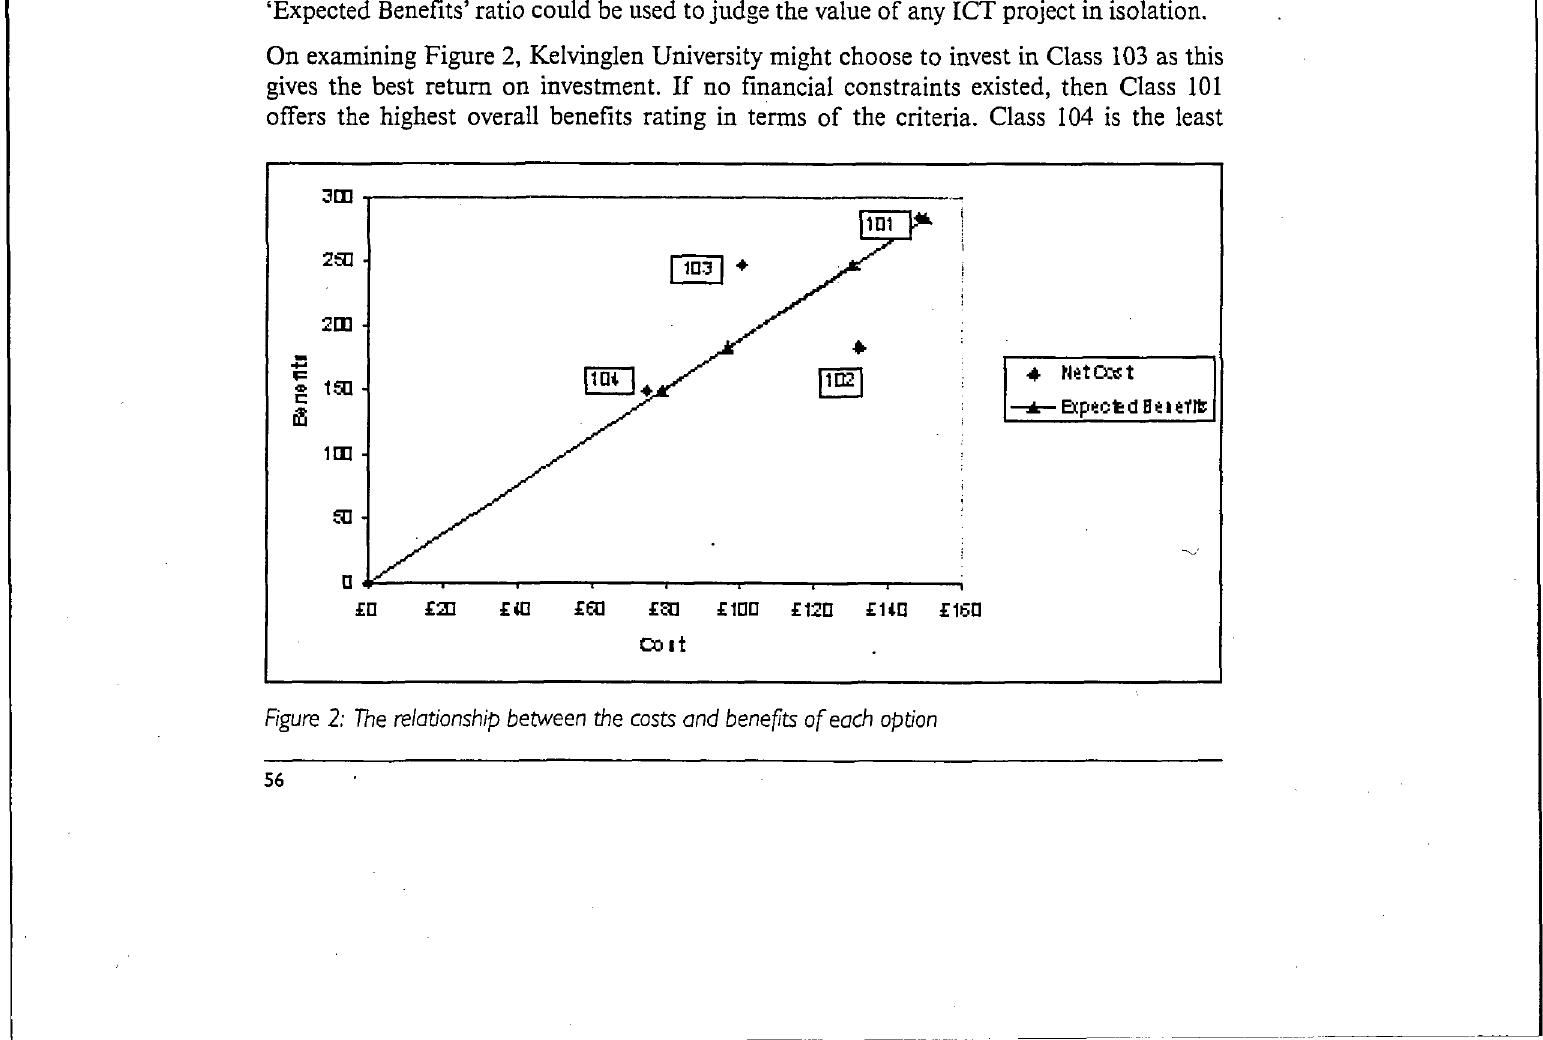
Step 6: plot the results graphically and discuss their meaning